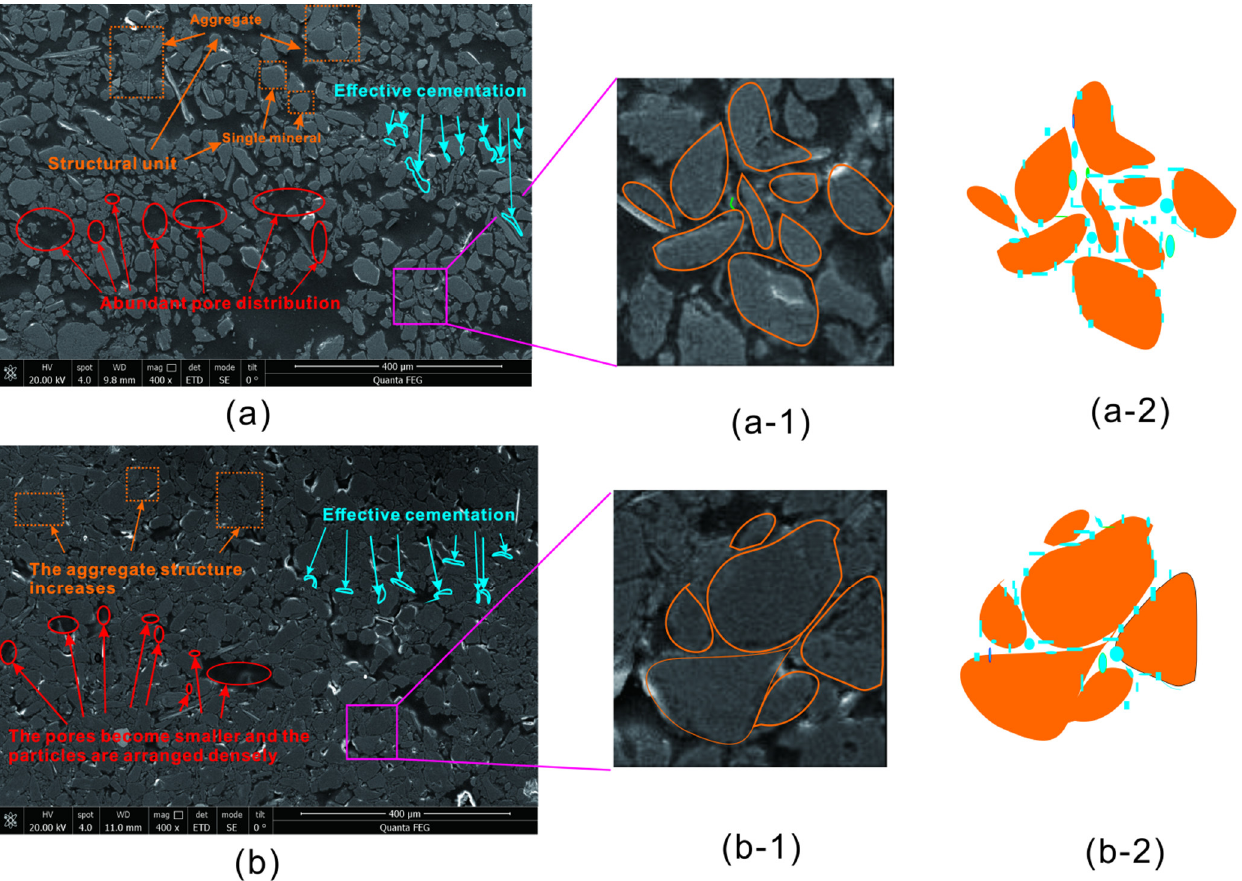
Figure 13. SEM images of ( a ) undisturbed and ( b ) remolded loess and concept diagrams of particle contact.